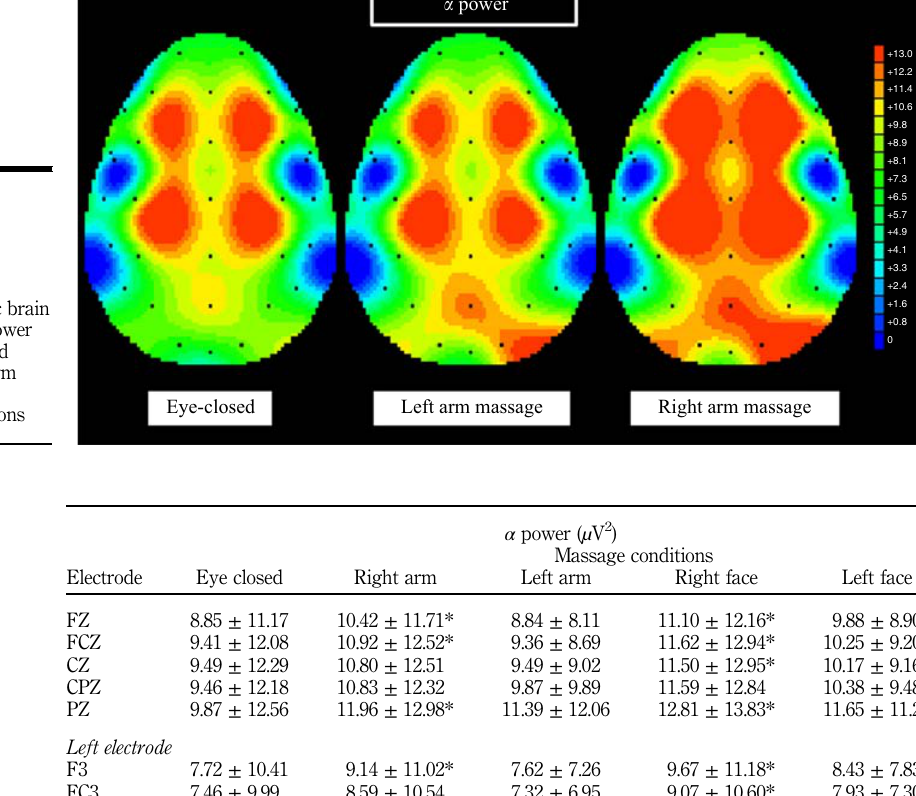
Table II. The α power over frontal (F), fronto- central (FC), central (C), centro-parietal (CP), parietal (P) and temporal (T) electrodes comparing between eye-closed and all massage